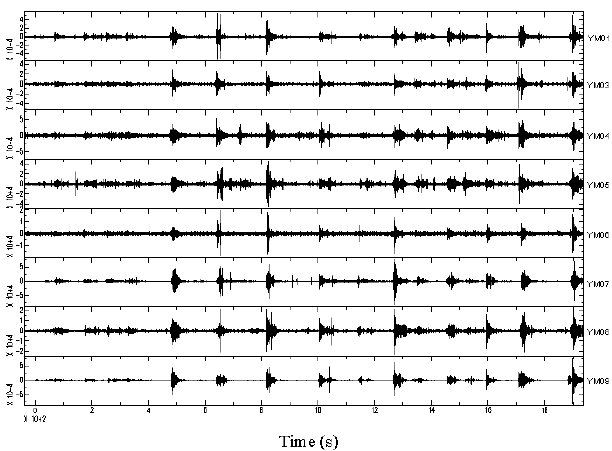
Fig. 3. Vertical velocity waveforms of a spasmodic burst with 30min duration that occurred on 2 May 2006. The names of each station that recorded the event are shown at the right side of each